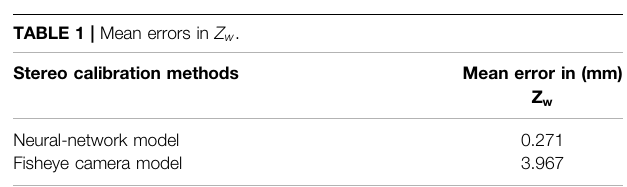
TABLE 1 | Mean errors in Z w